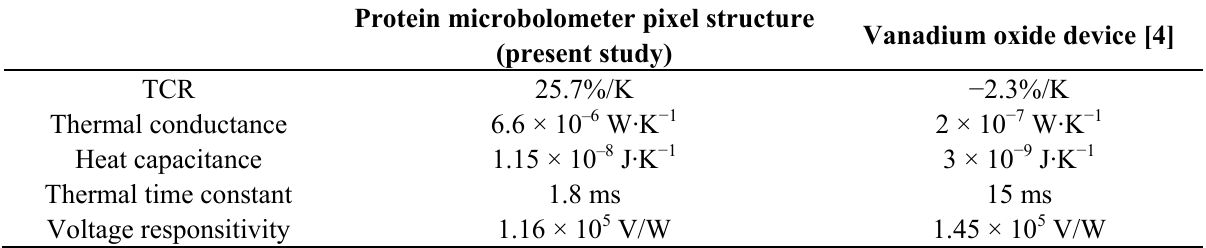
Table 3. Performance comparison of